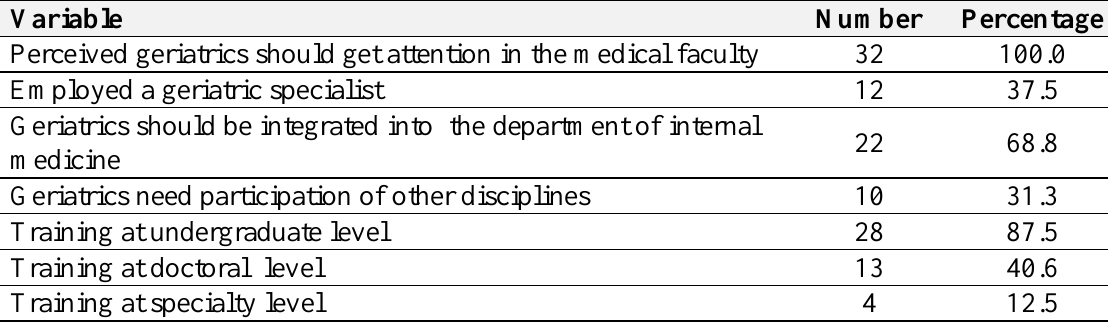
Table 1. Geriatric training at the faculties of medicine in Indonesia (N=32)